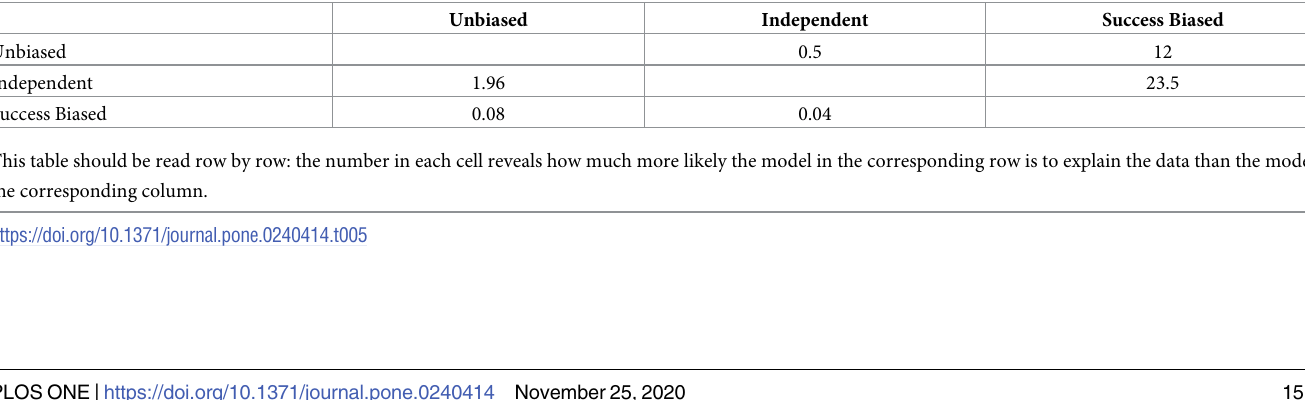
Table 5. Summary of the Bayes factors between all models.